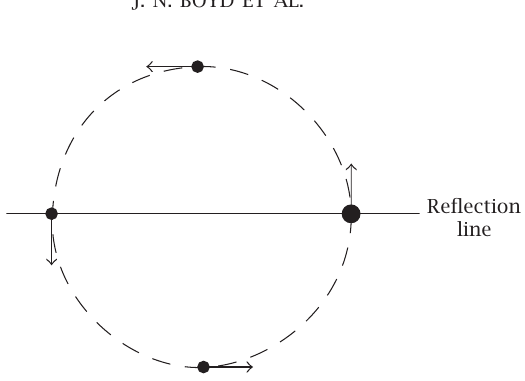
Figure 4.1 . The four particles with reflection